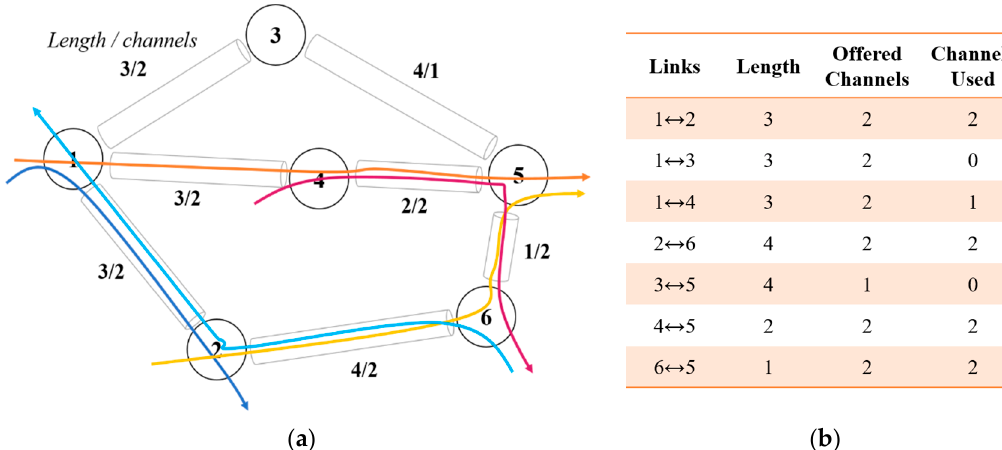
Figure 8. Physical network topology with 6 nodes and 7 bidirectional links. ( a ) Network Light path Establishment and ( b ) Network Traffic Table.